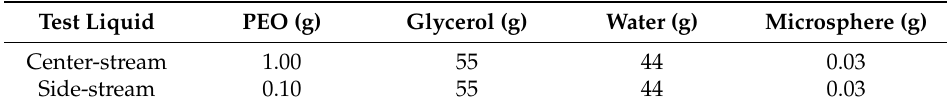
Figure 3. Plot of filament diameter over time as measured by CaBER for the test liquids. The fitted black line was used to obtain the extensional relaxation time for each liquid. Table 1. Composition of test